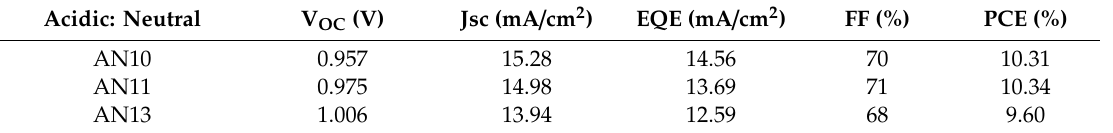
Figure 7. ( a ) Bandgap diagram of PSCs. ( b ) A schematic diagram of an inverted PSC. ( c ) Current-voltage (J–V) characteristics of PSCs under an AM 1.5 irradiation at 100 mW cm − 2 . ( d ) EQE (%) of PSCs depending on J–V characteristics. Table 1. Electrical parameters of the AN10, AN11, and AN13 PEDOT:PSS-based PSCs.